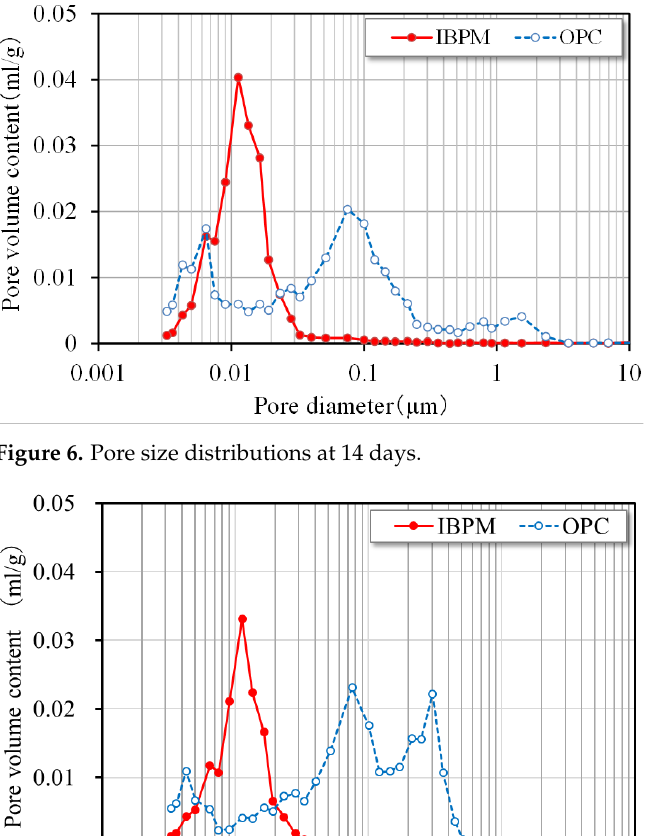
Figure 5. Results of powder X-ray diffraction.